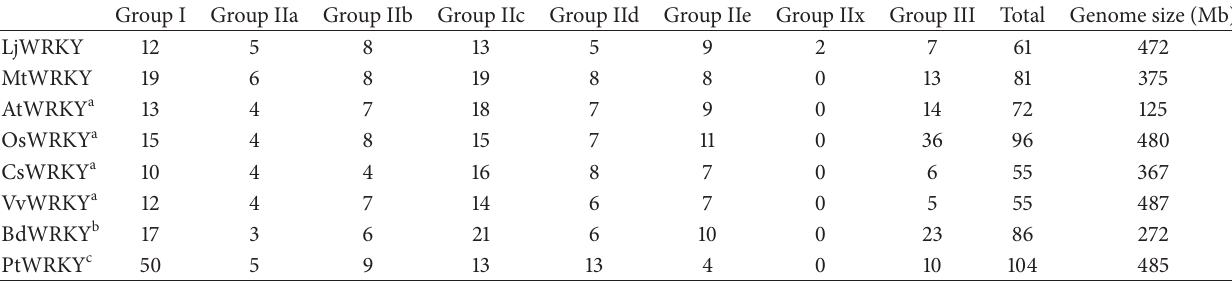
Table 2: The number of WRKY gene in eight